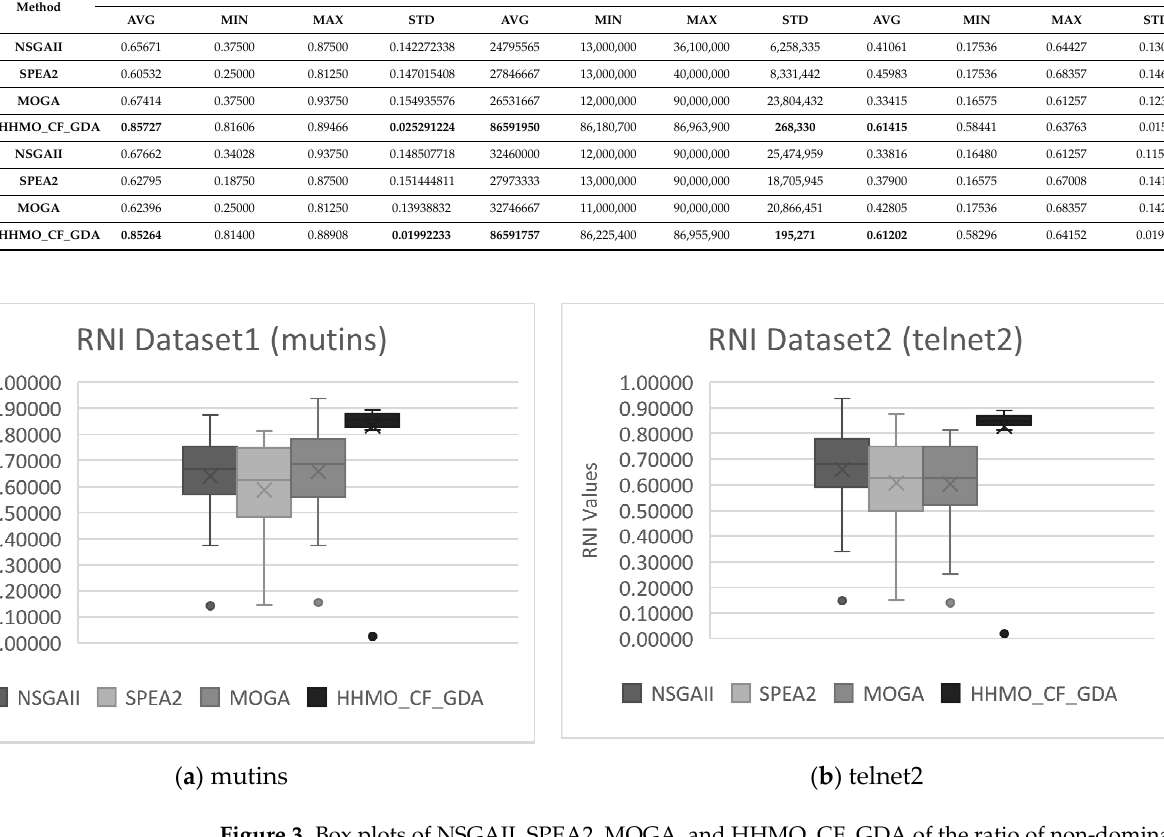
Figure 3. Box plots of NSGAII, SPEA2, MOGA, and HHMO_CF_GDA of the ratio of non-dominated individuals (RNI) on the mutins and telnet2 datasets: ( a ) mutins box plots; ( b ) telnet2 box plots.